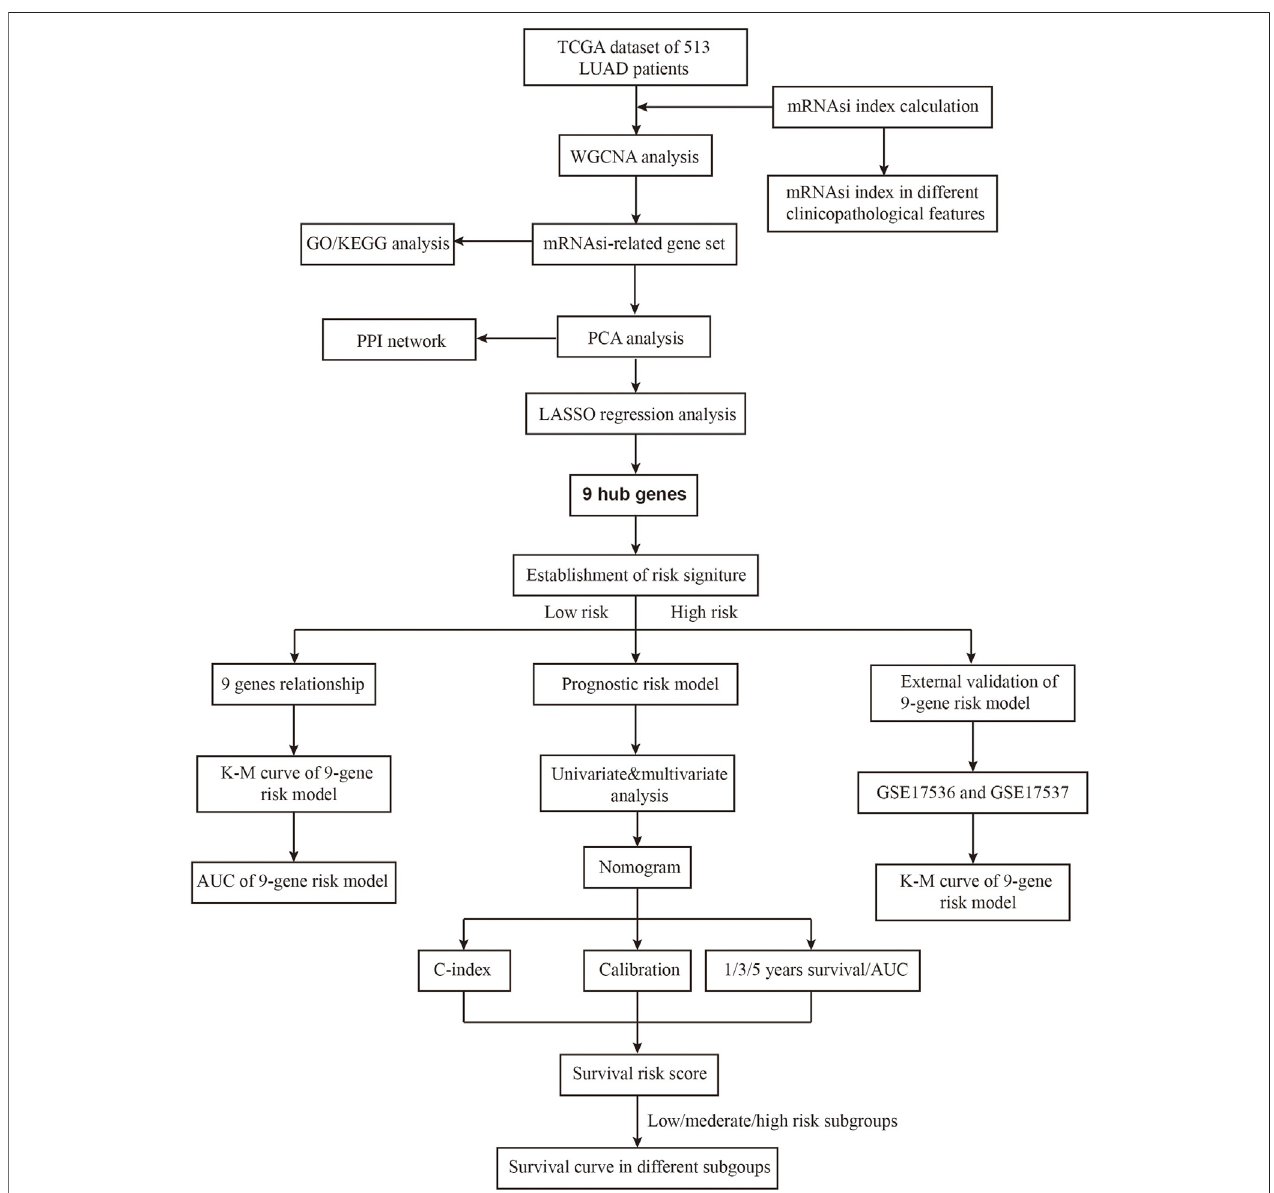
FIGURE 1 | The fl owchart of this